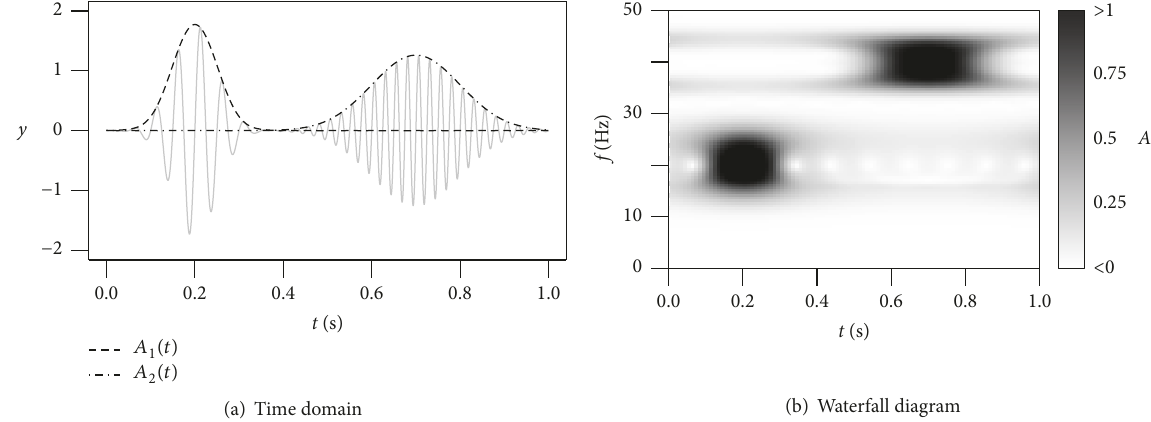
Figure 13: Basic simple example of a nonstationary signal (a) with its time depending spectral decomposition in (b). The different line types of the envelope correspond to the first and second